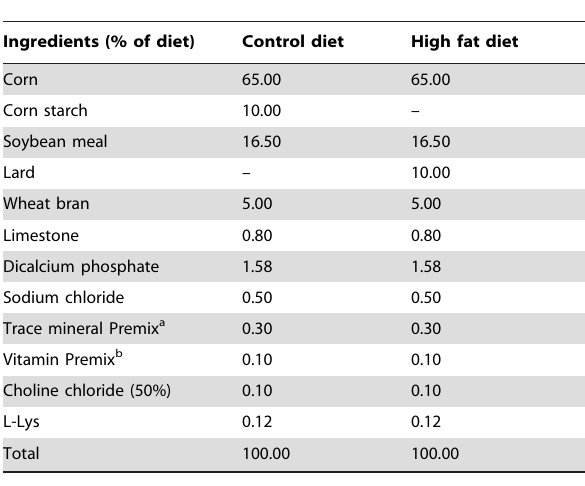
Table 1. Composition of experimental diet (as fed-basis).